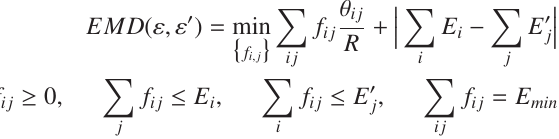
Figure 4. Earth Mover Distance distribution as described in Ref. [24]. Low values of EMD indicate good